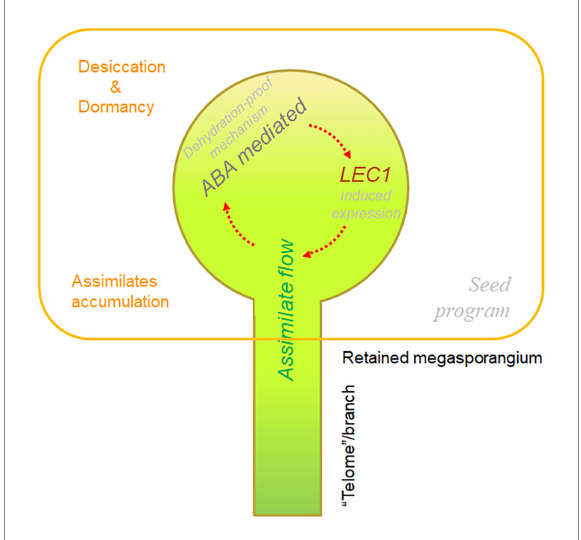
FIGURE 6 Diagram of the “golden-trio hypothesis” on the origin of the “seed program.” The “golden trio” refers to three indispensable components for seed program: assimilate flow, ABA-mediated dehydration-proof mechanism, and inductive expression of LEC1 -like genes. Interactions among the three components, together with other factors, triggered the seed program overlapping with embryonic development, resulting in emergence of the seed